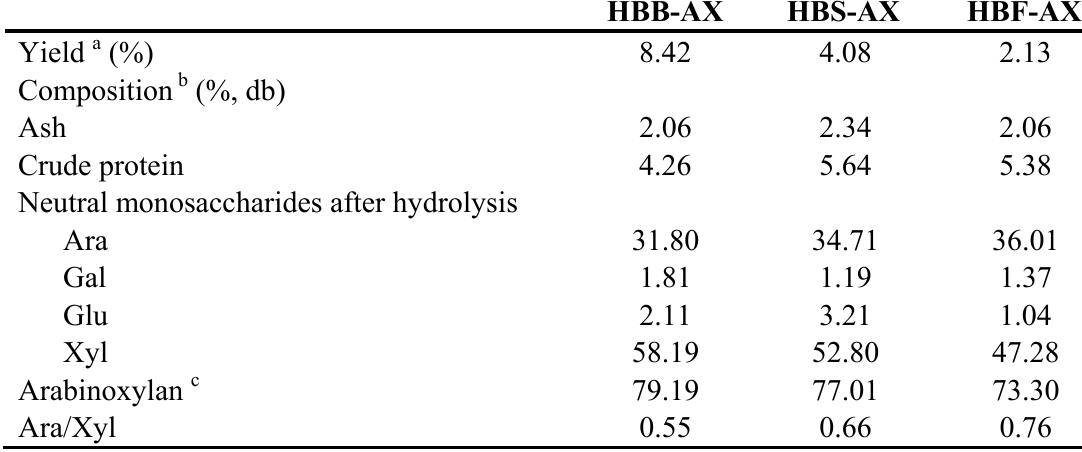
Table 2. Chemical composition of HBB-AX, HBS-AX, and